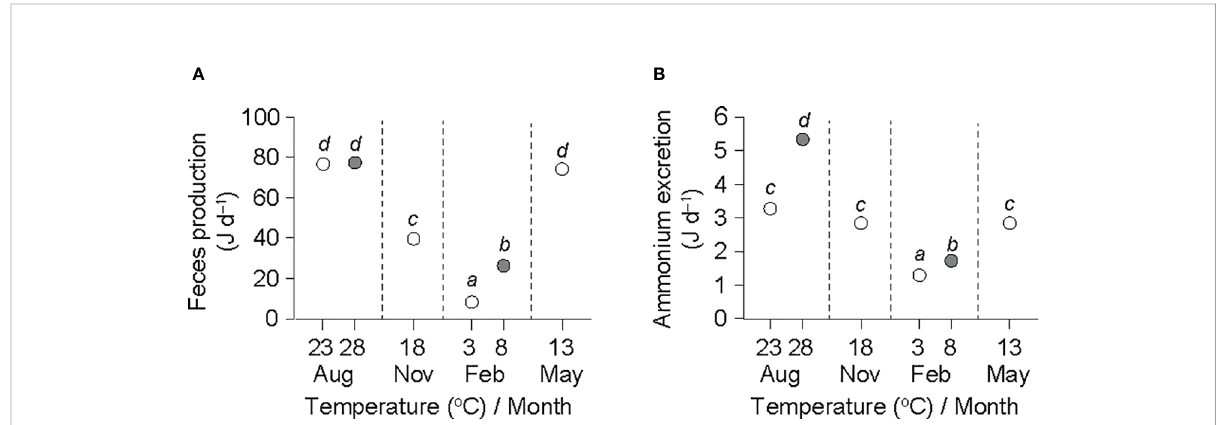
FIGURE 3 Rates of feces production (A) and ammonium excretion (B) in an individual ark shell ( Anadara kagoshimensis ) with a dry- fl esh weight of 0.6 g recorded in all six experimental groups in August and November 2017, and February and May 2018. The rates were re-calculated using common (cid:1) b and re-estimated ( (cid:1) a ) values from Table 2. The open and closed circles of August and February represent cold and warm conditions in summer and winter, respectively. Sample size, n = 9 in each group. The same letters indicate the absence of signi fi cant differences between means (Bonferroni test, P <